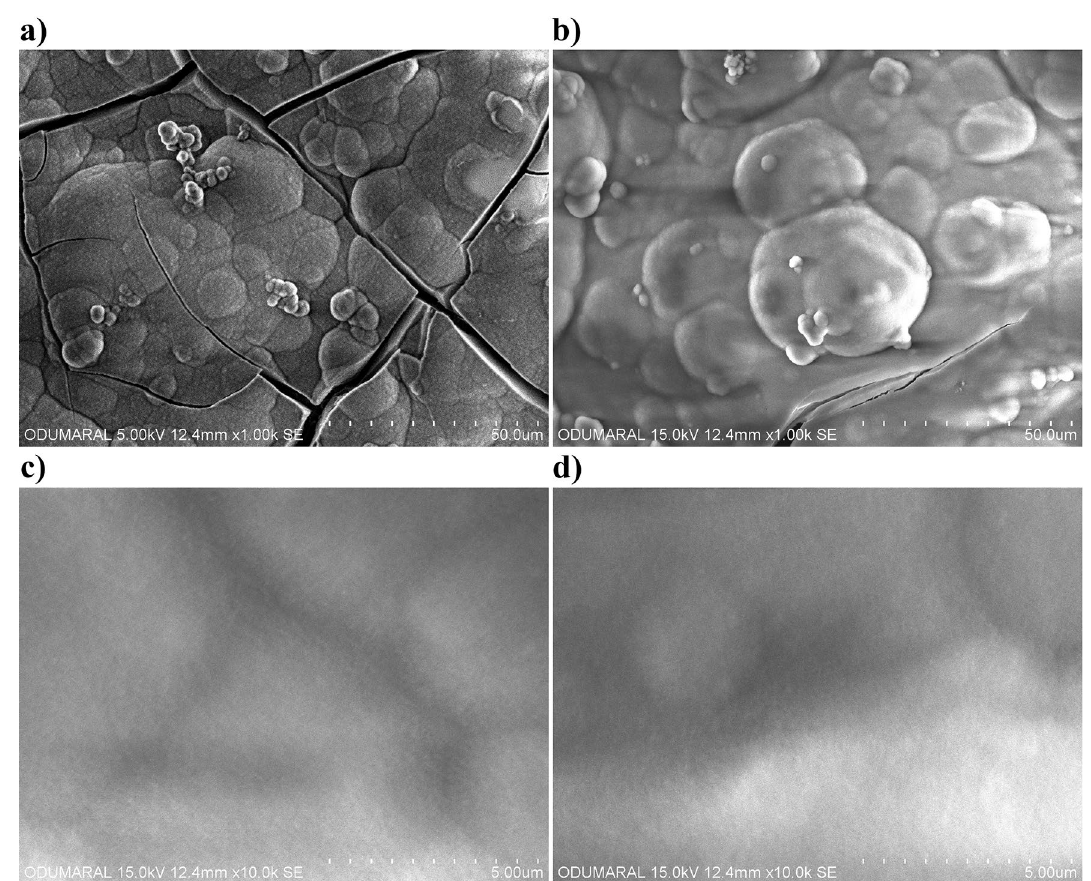
Figure 7. The surface morphologies of the coatings immersed in SBF for 14 days: ( a , c ) for the MAO and ( b , d ) for chitosan-based MAO